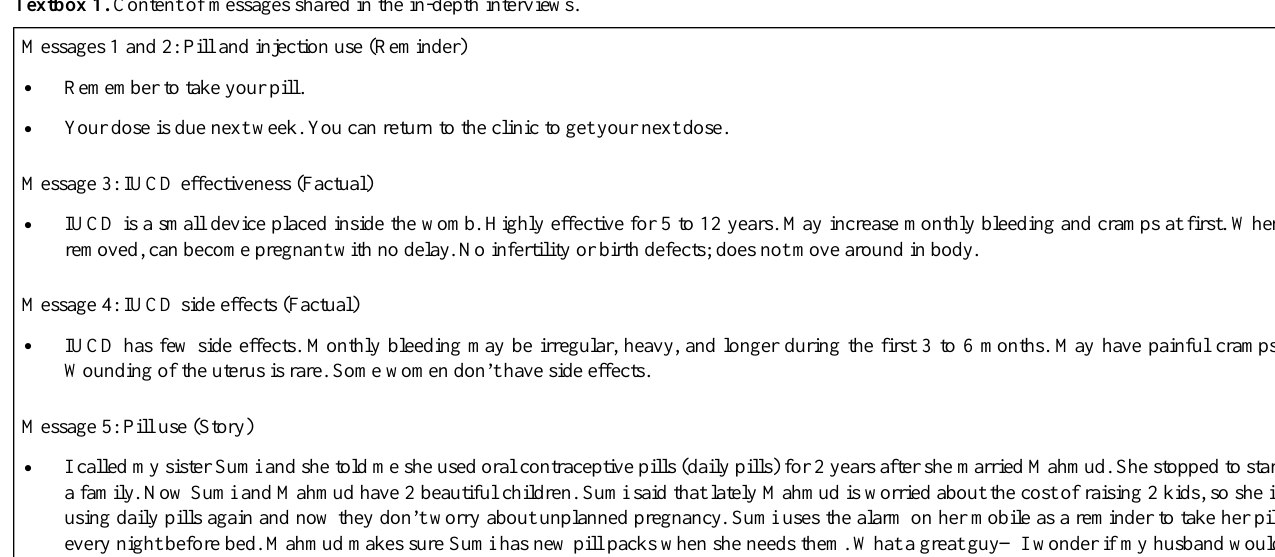
Textbox 1. Content of messages shared in the in-depth